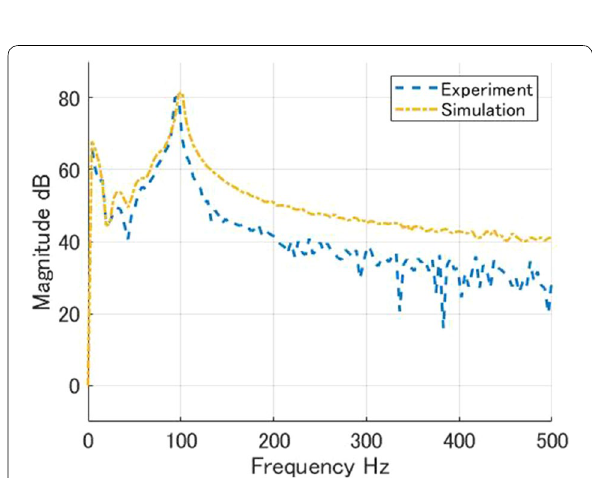
Fig. 13 Amplitude spectrum of force reference F 1 in Case 2-2